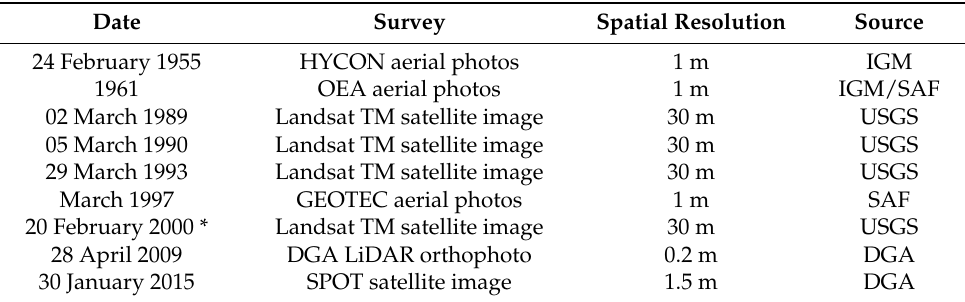
Table 1. Overview of the data sets used for glacier area change mapping. Glacier areas were estimated from the orthorectified and georeferenced